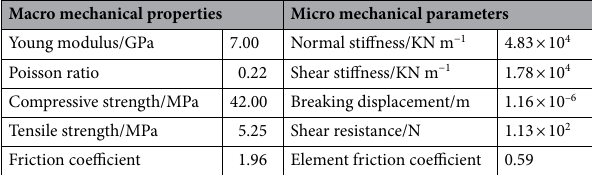
Table1. Macro and micro mechanical properties of the sample.